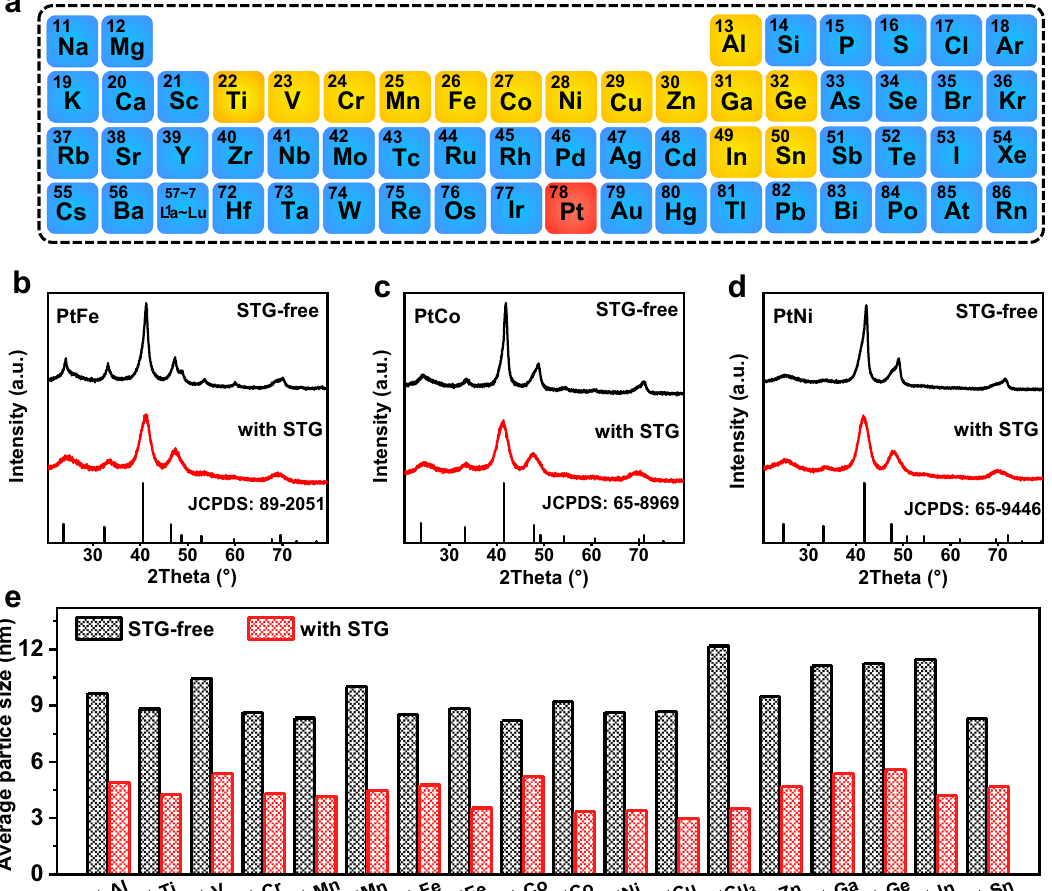
Fig. 2 | STG-assisted synthesis of Pt-IMCs catalyst libraries. a Periodic table showingPt(highlightedinred)andbasemetalelements(highlightedinyellow)that constitute Pt-IMCs catalysts libraries. Comparison of the XRD patterns of PtFe ( b ),